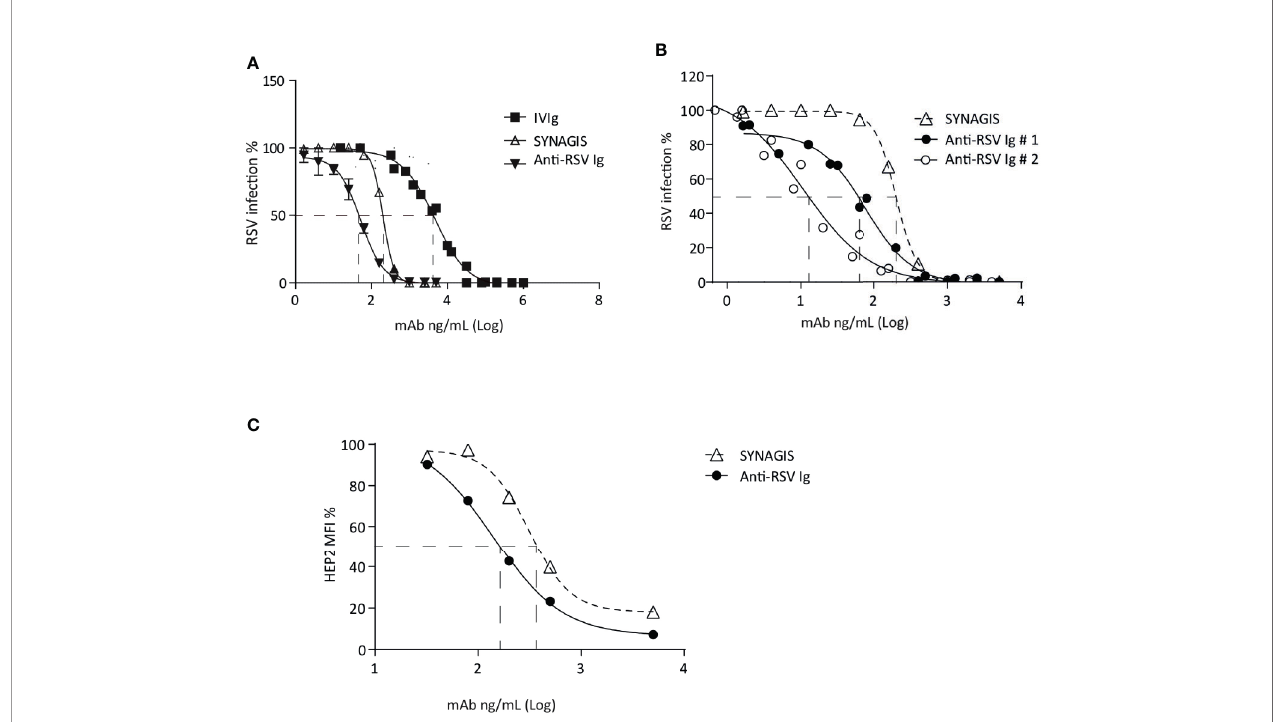
FIGURE 2 | Hyper-enriched anti-RSV Ig characterization. (A, B) The biological activity of anti-RSV Ig products was measured by in vitro neutralization test assessed on HEp-2 cells and using recombinant RSV-cherry. (A) The antiviral activity of the hyper-enriched anti-RSV Ig solution was compared to the starting solution (IVIg) and the antibody control, Synagis ® . (B) The neutralizing capacity of two batches of hyper-enriched anti-RSV Ig was compared to Synagis ® . Data are representative of 2 independent assays. (C) To determine the ability of the anti-RSV Ig product to neutralize a clinical isolate of RSV, the neutralization assay was performed by fl ow cytometry on HEp-2 infected cells after immunodetection of RSV-F protein. Results were expressed in MFI, 100 arbitrarily being the MFI obtained with RSV-infected HEp-2 cells without incubation with anti-RSV antibodies. Data are representative of 2 independent